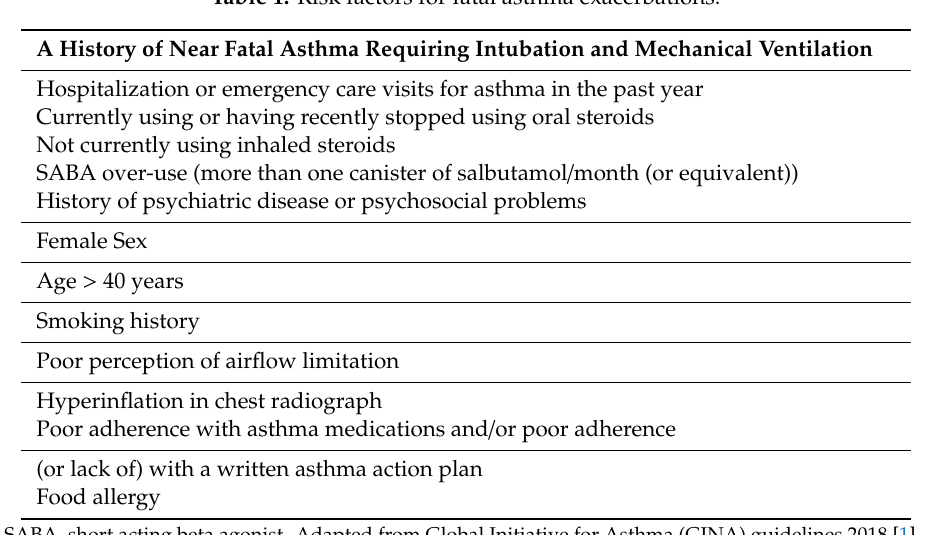
Table 1. Risk factors for fatal asthma